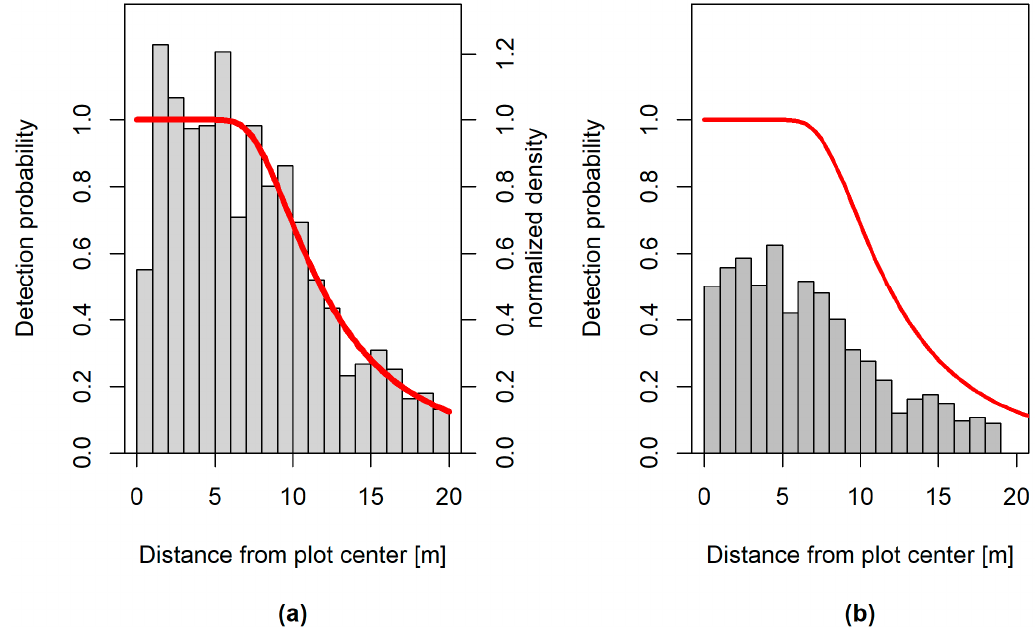
Figure 1. Hazard rate-type detection function g hr ( r ) (red line) for all trees having a diameter at breast height (dbh) ≥ 5 cm. ( a ) g hr ( r ) fitted to the normalized density of observed distances between the plot center (i.e., scanner position) and detected trees (gray columns); ( b ) g hr ( r ) compared with the observed detection probabilities at di ff erent distances, computed from annuli of 1 m width (gray columns).